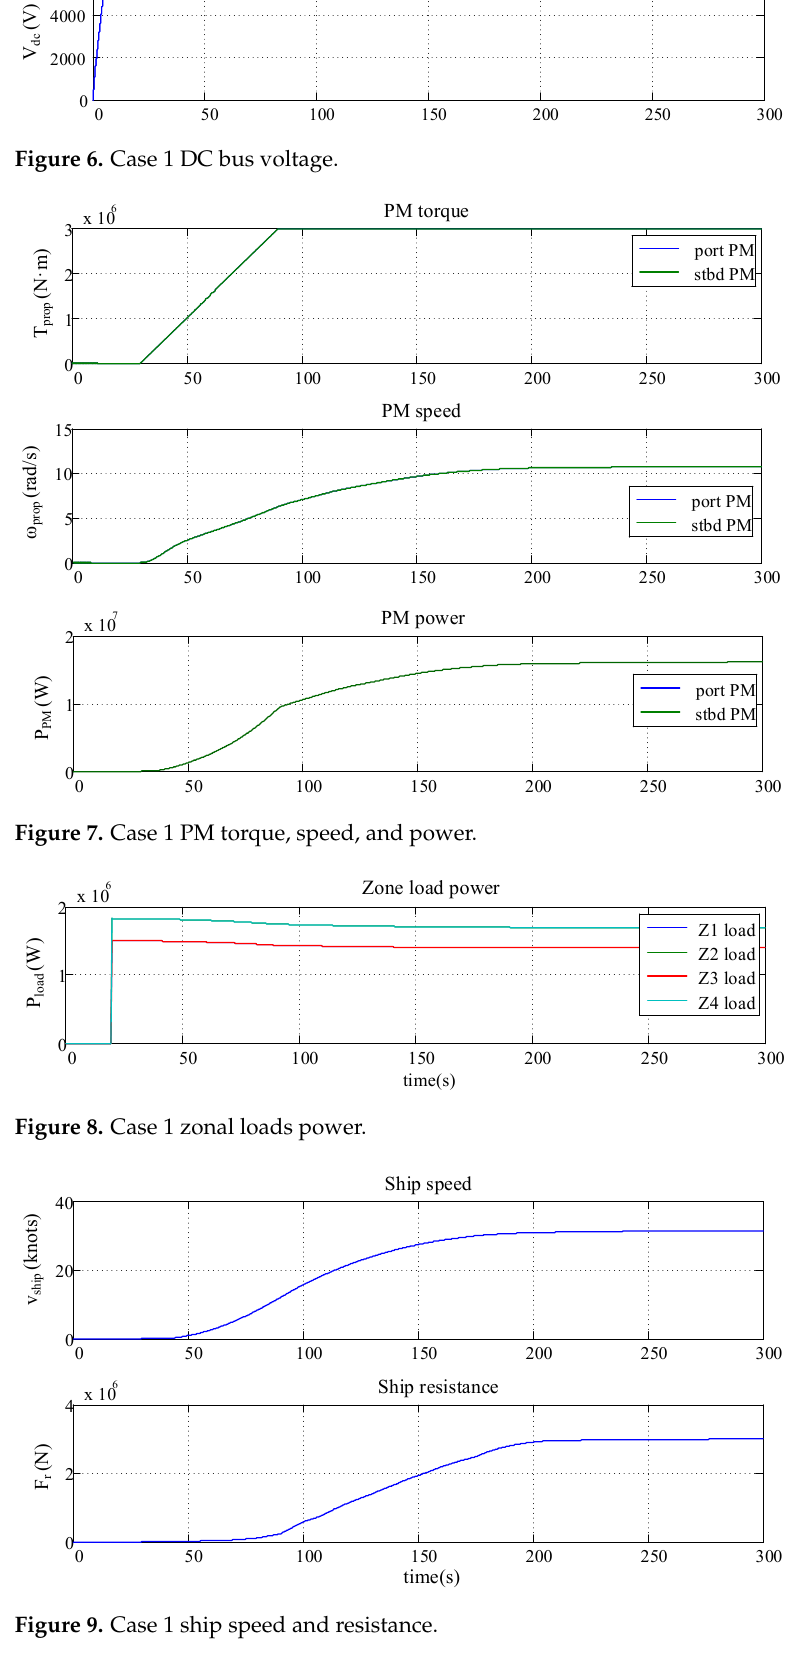
10 of 18 Figure 4. Case 1 gas turbine speed, torque, and power.